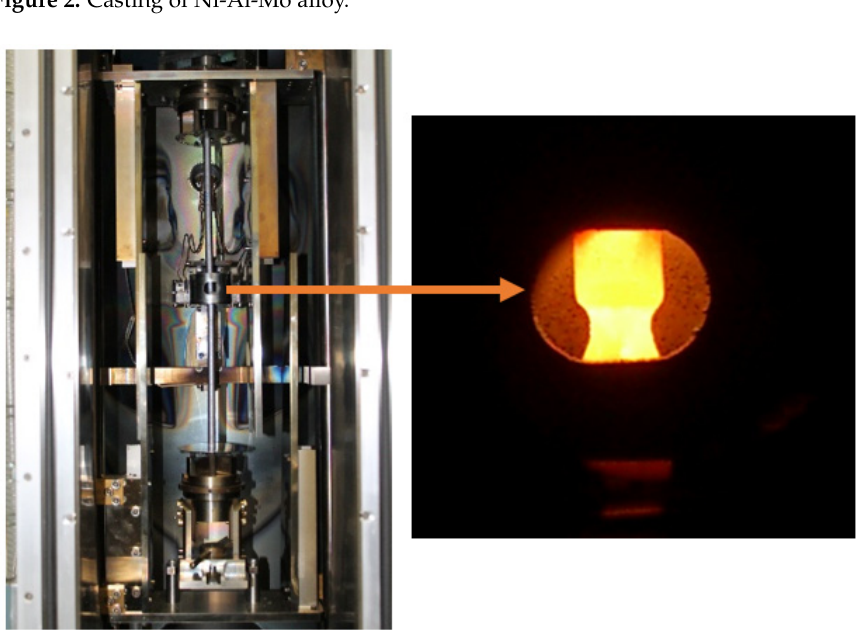
Figure 3. The placement of sample in the EBFZM furnace and the shape of melting zone.